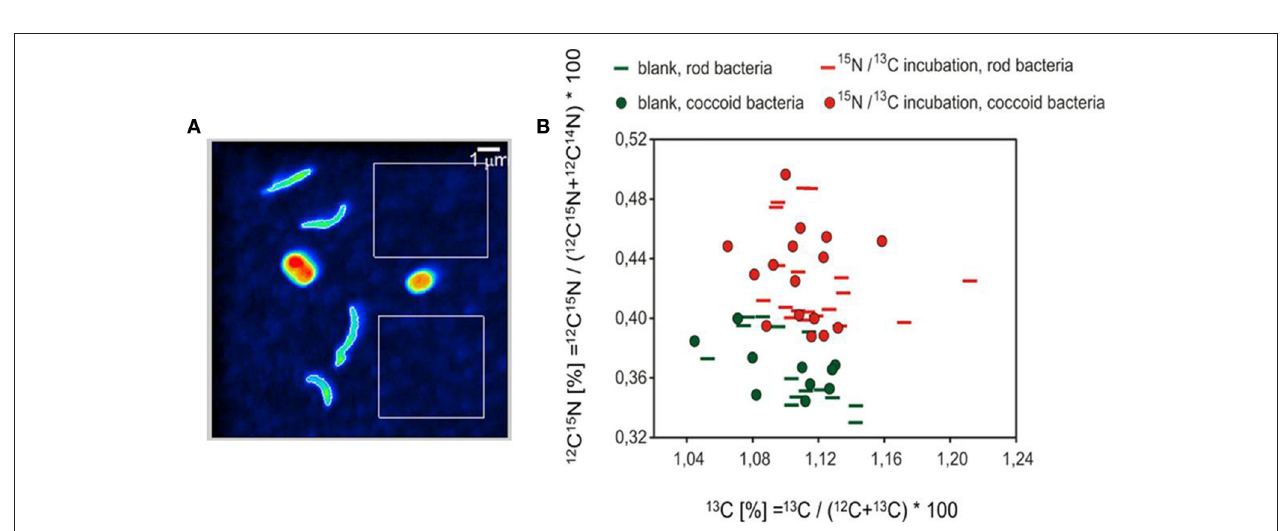
FIGURE 6 | Phylogenetic analysis based on 16S rRNA sequences gained from the stable isotope probing. 13 C-enriched organisms are denoted by red rectangles. Black dashed rectangles denote “unlabeled” organisms.